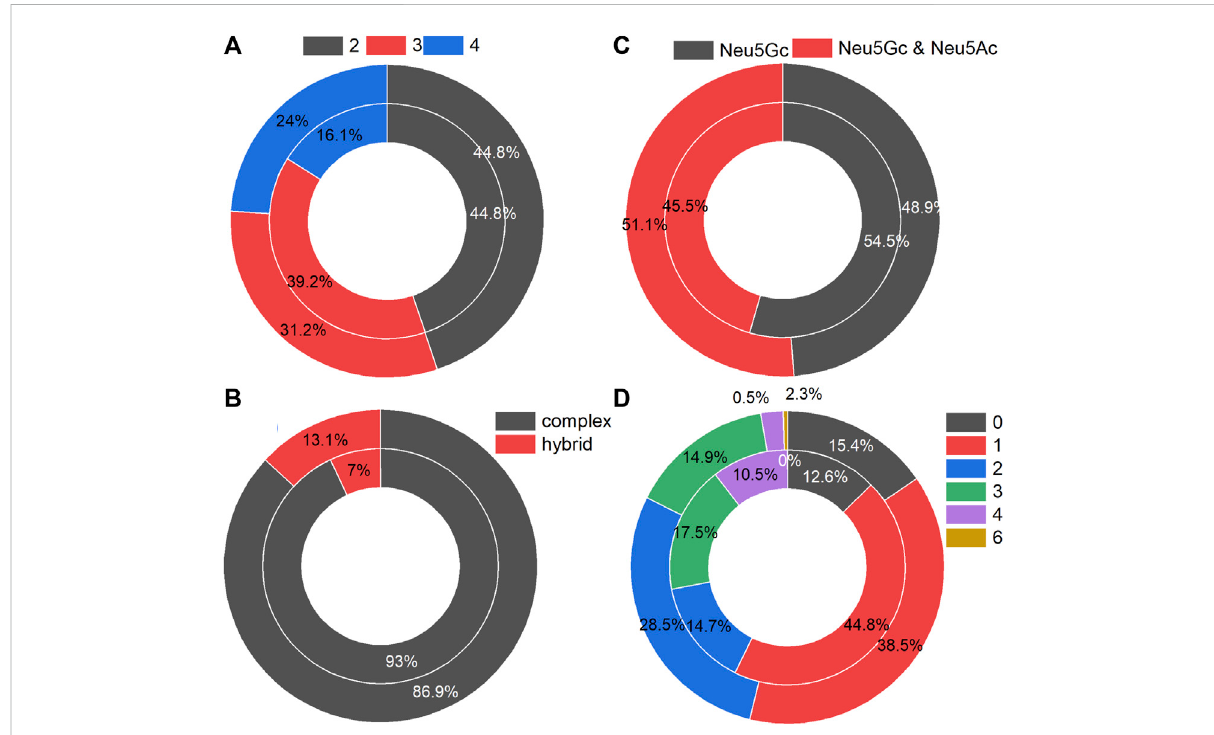
FIGURE 2 StatisticsofN-glycansinintactN-glycopeptideswithNeu5Gcidenti fi edfromMCF-7(innercircle)andMCF-7CSCs(outercircle): (A) numberof branches per N-glycan, (B) with Neu5Gc only or additional Neu5Ac, (C) N-glycan-type, (D) number of fucoses per